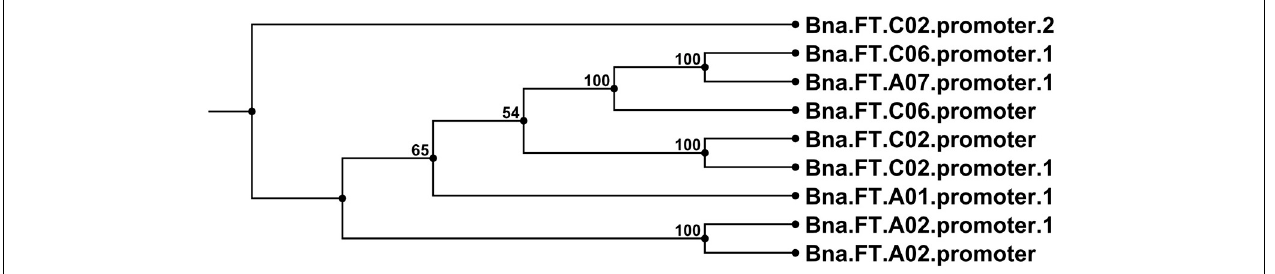
FIGURE 8 | Neighbor joining tree diagram of promoter sequences from all detected copies of the flowering gene FT in comparison with promoters from previously known Bna.FT loci retrieved from NCBI. Sequences